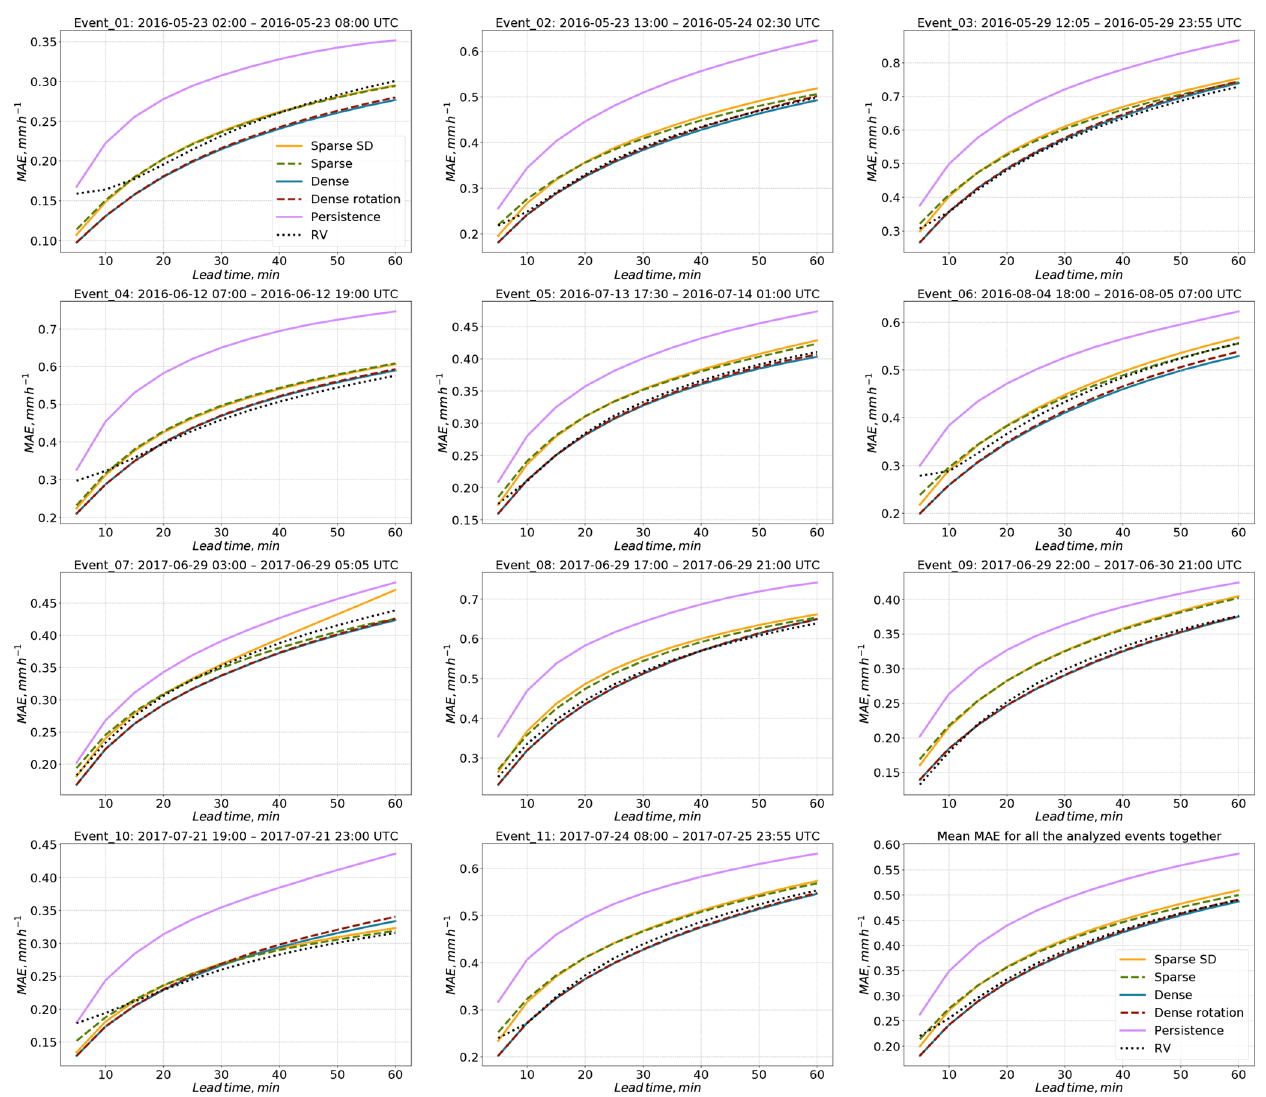
Figure 6. Verification of the different optical flow based nowcasts in terms of MAE for 11 precipitation events over